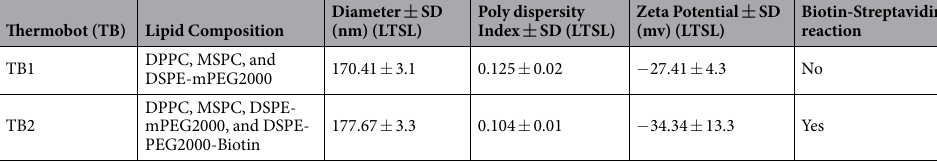
Table 1. Cross-linking schemes for Thermobot